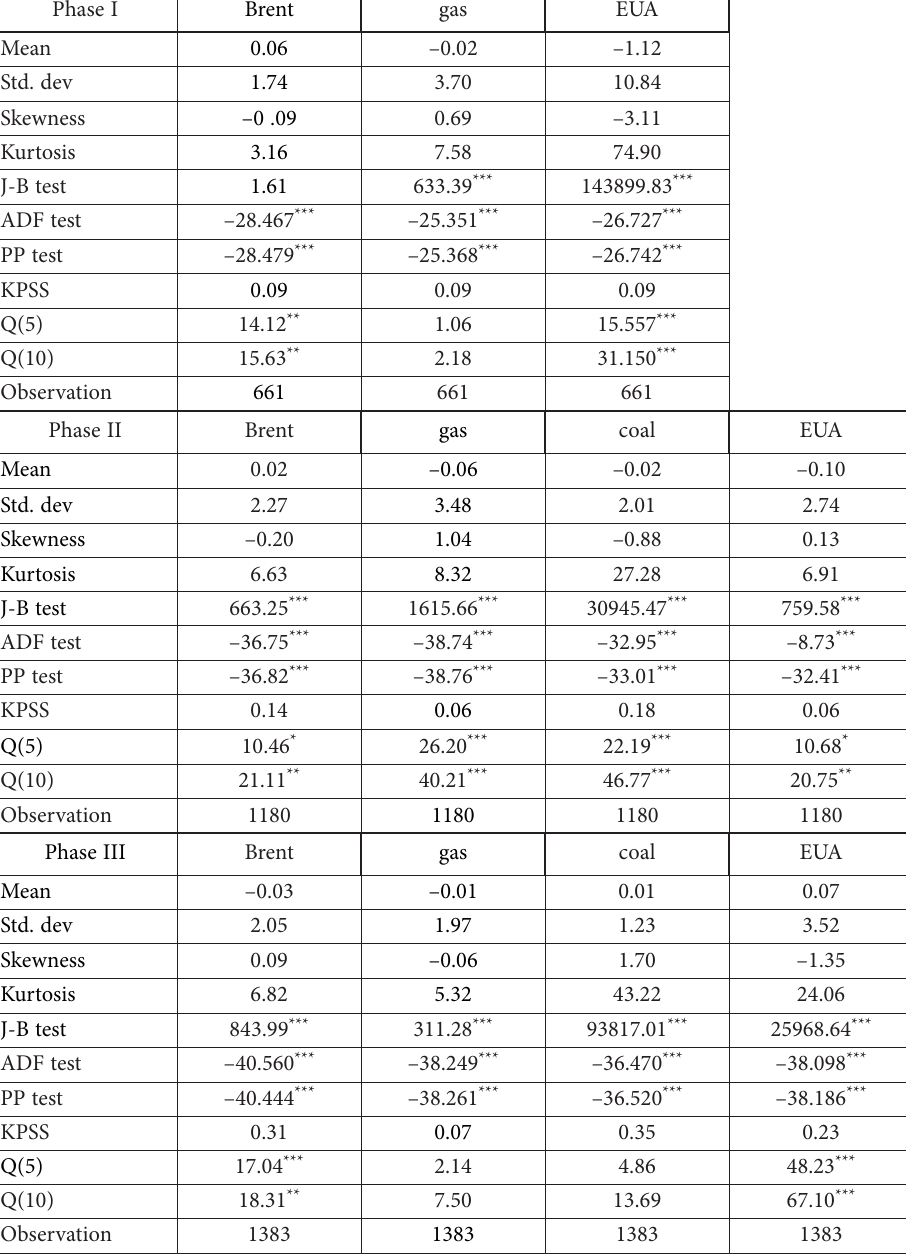
Table 2. Descriptive Statistics for the Daily Log Returns of the EUA and the Energy Futures Phase